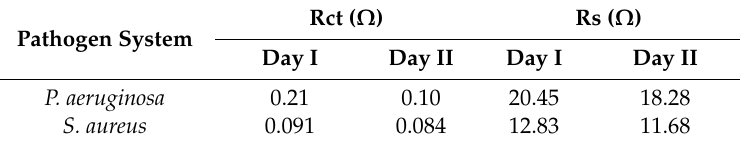
Table 1. Charge transfer (Rct) and solution resistance (Rs) values of SnIn5 based